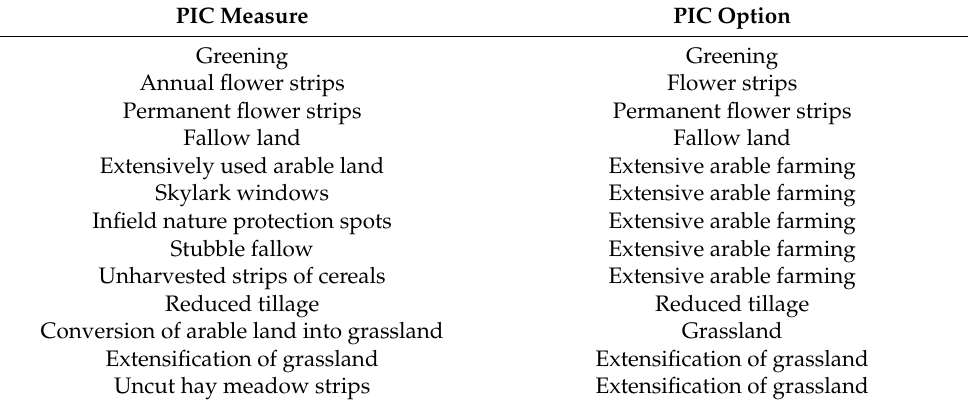
Table 2. Grouping of the measures in PIC